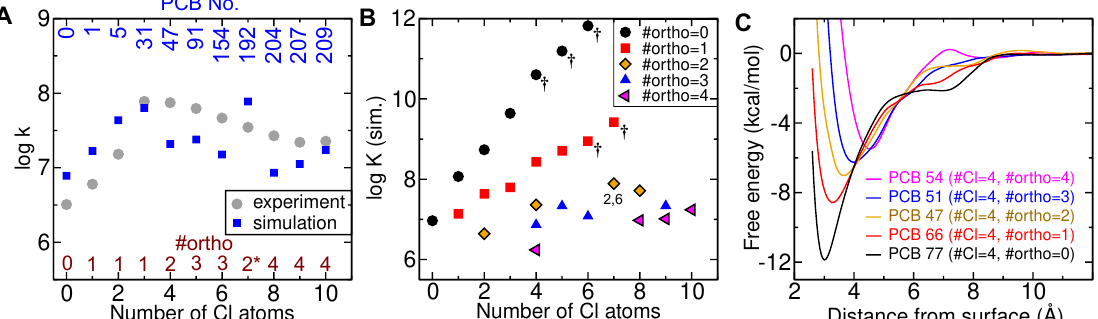
Figure 5. Molecular dynamics simulations of PCB adsorption on a model ZnO surface. ( A ) Comparison of adsorption coefficients determined from the experiment and calculated from the simulations. (*) PCB 192 has its two chloro substitutions on the same phenyl group (2,6). All other PCBs with # ortho = 2 considered here have one chloro substitution on each phenyl group (2,2 (cid:48) ). ( B ) Simulation-derived adsorption coefficients for a range of PCBs marked with symbols indicating the number of ortho substitutions. (†) Dioxin-like PCBs. This plot includes all of the simulation data in panel A as well as many additional points with different numbers of ortho substitutions. ( C ) Simulation-derived free energies as a function of distance between a model ZnO surface and select tetrachlorobiphenyls with different numbers of ortho